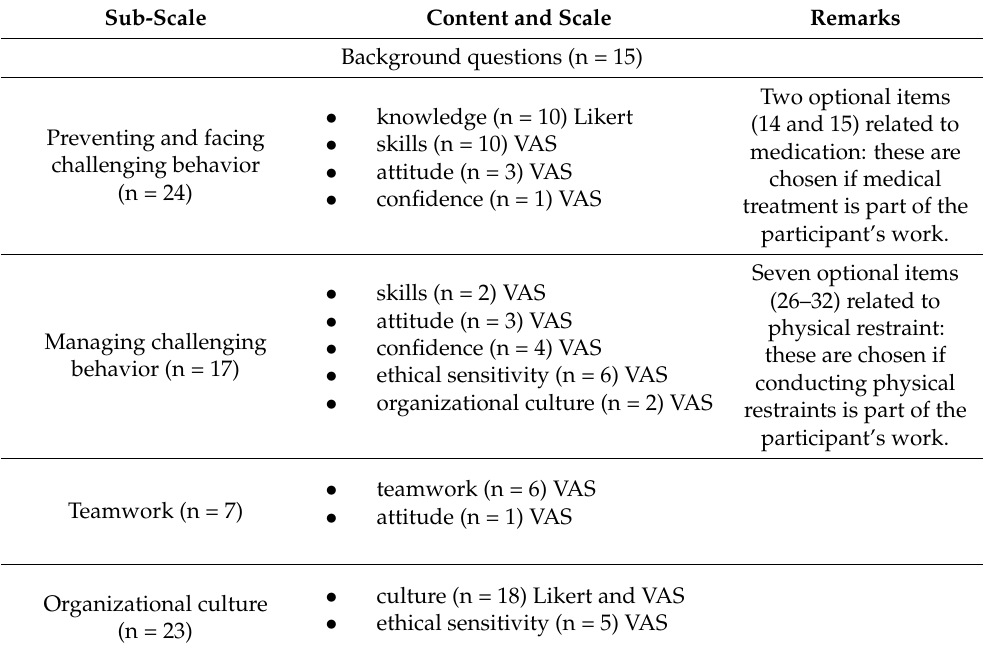
Table 2. Structure of the version III of